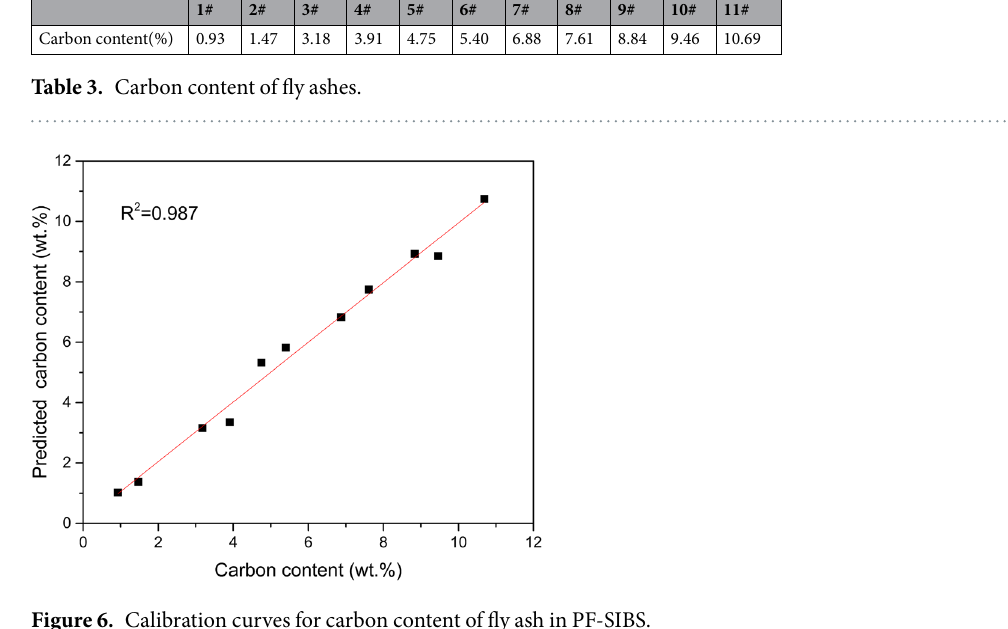
Figure 6. Calibration curves for carbon content of fly ash in